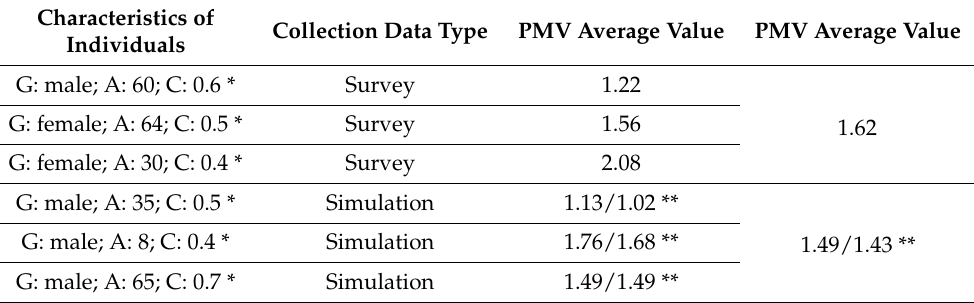
Figure 9. The output of air temperatures within the Materdei area, at heights 0.00 and +4.50. Table 3. Comparison of PMV data for the Materdei area extracted from the questionnaire and simulations for interviewees and simulated persons.